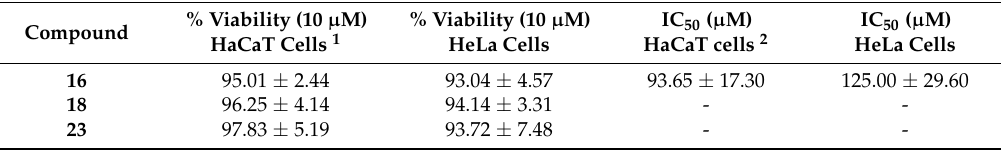
Table 4. Results for cytotoxicity assays in HaCaT and HeLa cell